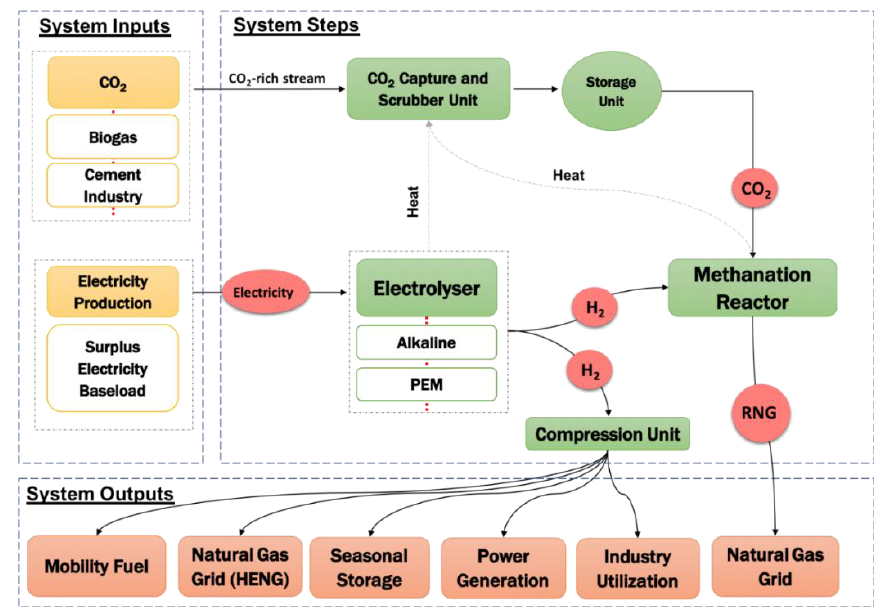
Figure 1 . Power-to-gas Energy System [8,11]. Figure 1. Power-to-gas Energy System